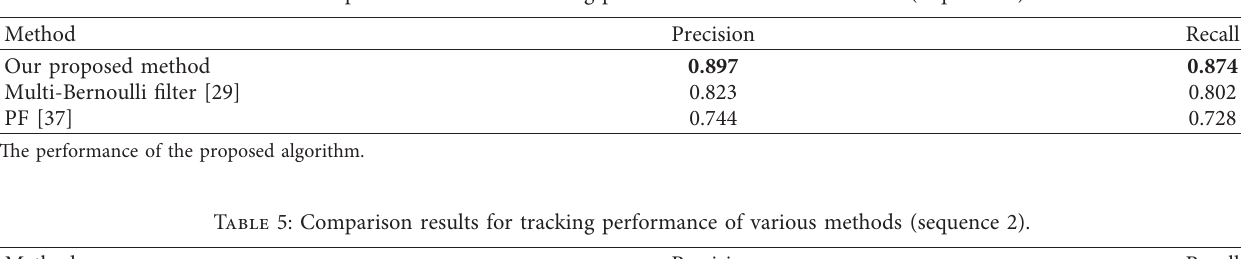
Figure 12: Comparison of cells number estimates using various Table 4: Comparison results for tracking performance of various methods (sequence 1).